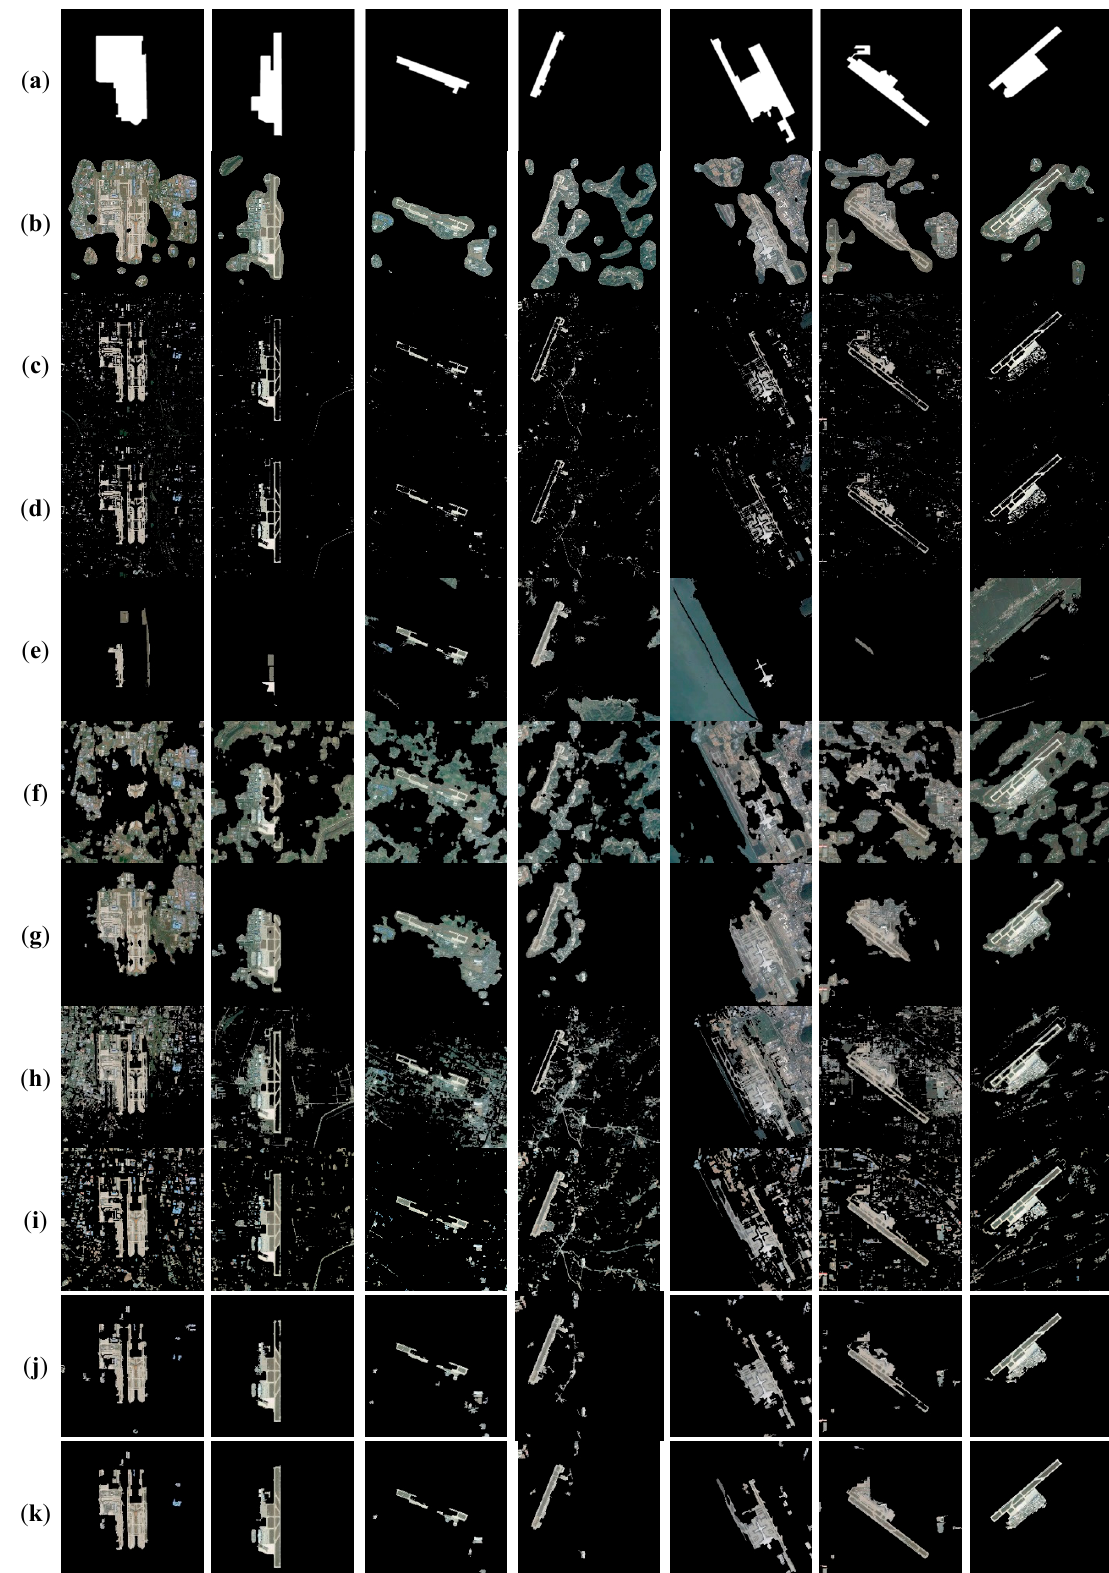
Figure 15. Visual comparison of ROIs from Group Google Earth-Airport . From top to bottom are ( a ) manual ground truth masks; ( b ) ITTI; ( c ) FT; ( d ) MSSS; ( e ) CB; ( f ) SIM; ( g ) CA; ( h ) TMM; ( i ) FDA-SRD, ( j ) JMS; and ( k ) EP-JMS.